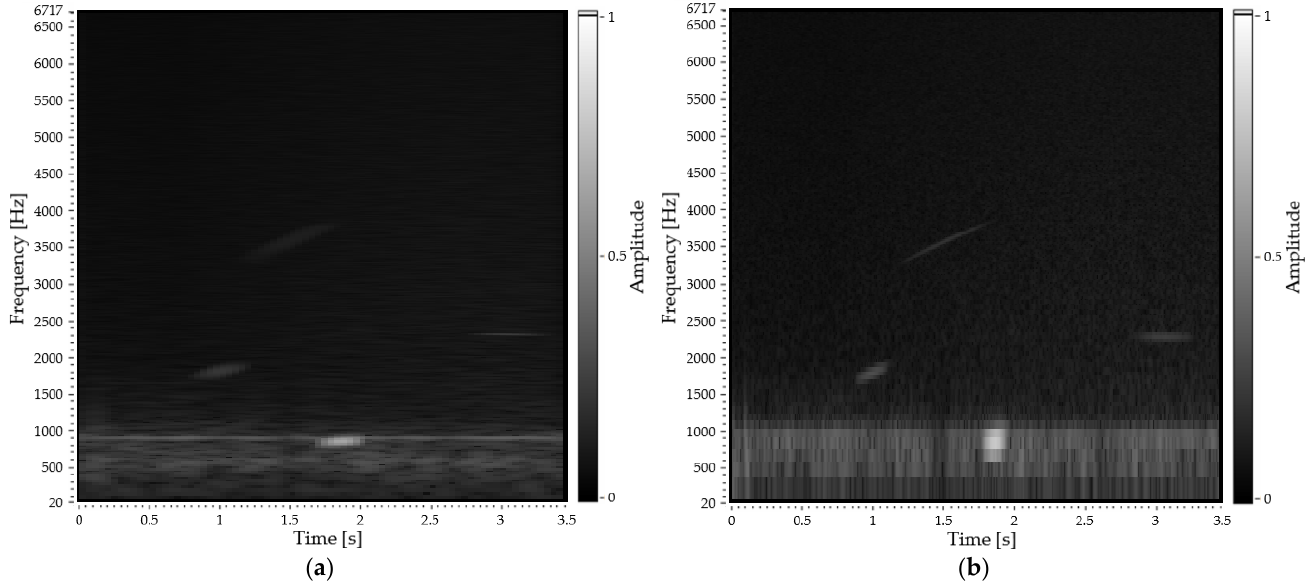
Figure 7. A sample of spectrogram 1 ( a ) and spectrogram 2 ( b ), where intensity of EN is damped to − 10 dB from the nominal level.